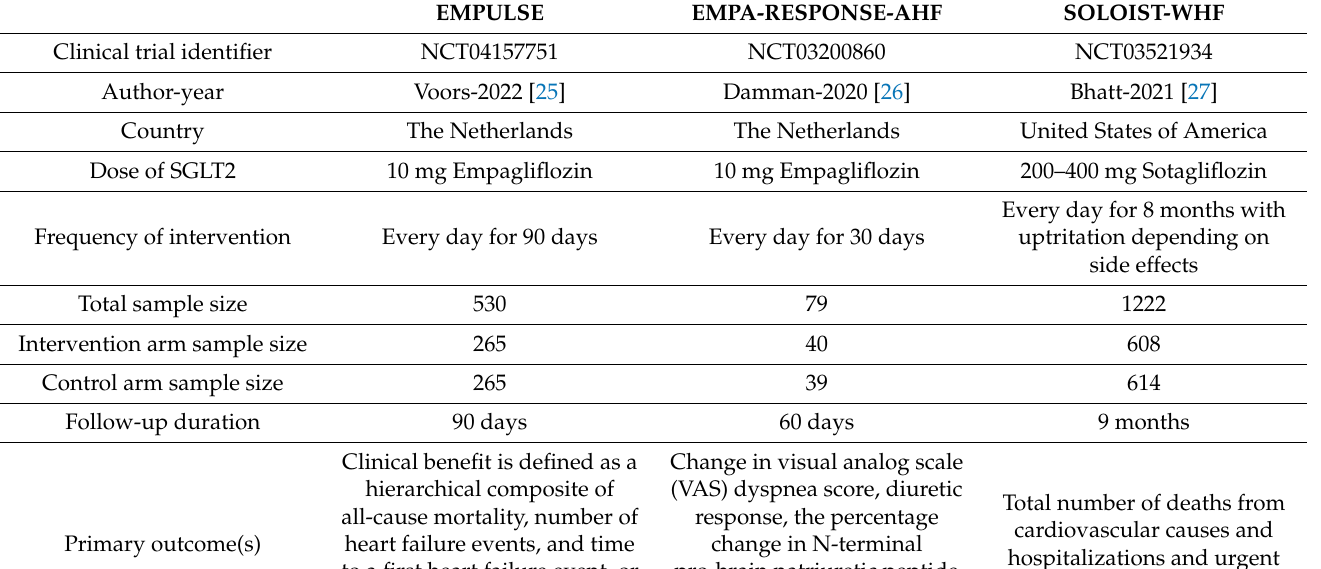
Table 1. Trial characteristics of the included studies. Only patients who had acute heart failure with or without diabetes were included in the trials.